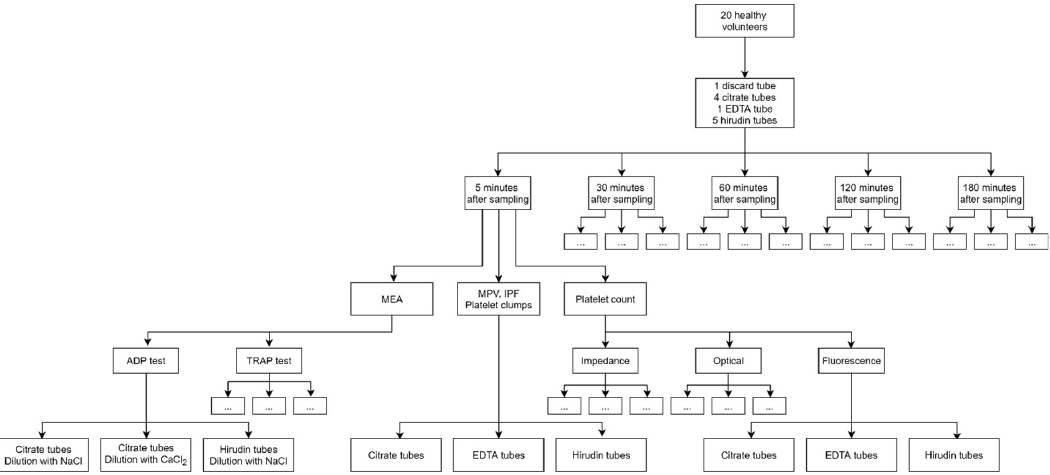
Figure 1. Study design. Empty boxes just repeat the same elements as adjacent boxes. MEA: multiple electrode aggregometry; MPV: mean platelet volume; IPF: immature platelet fraction; EDTA: ethylenediaminetetraacetic acid; ADP: adenosine diphosphate; TRAP: thrombin receptor activating peptide.